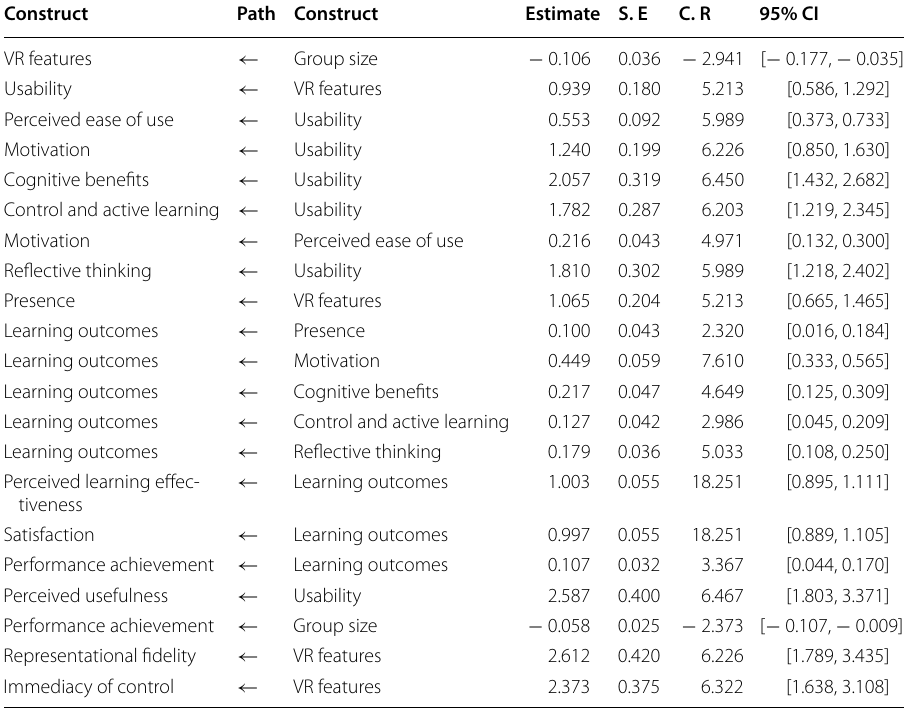
Table 4 Unstandardized estimates, standard errors, critical ratios and confidence intervals of the paths in the